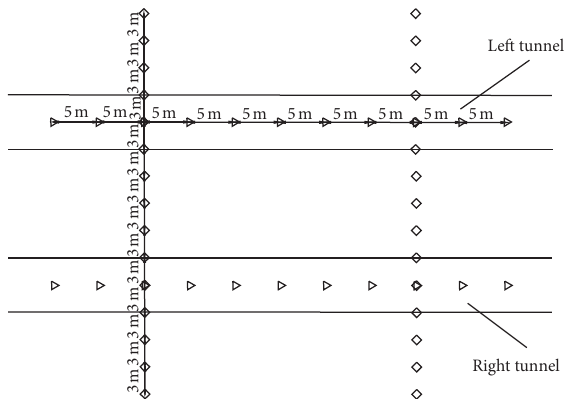
Figure 5: Longitudinal layout of ground subsidence monitoring